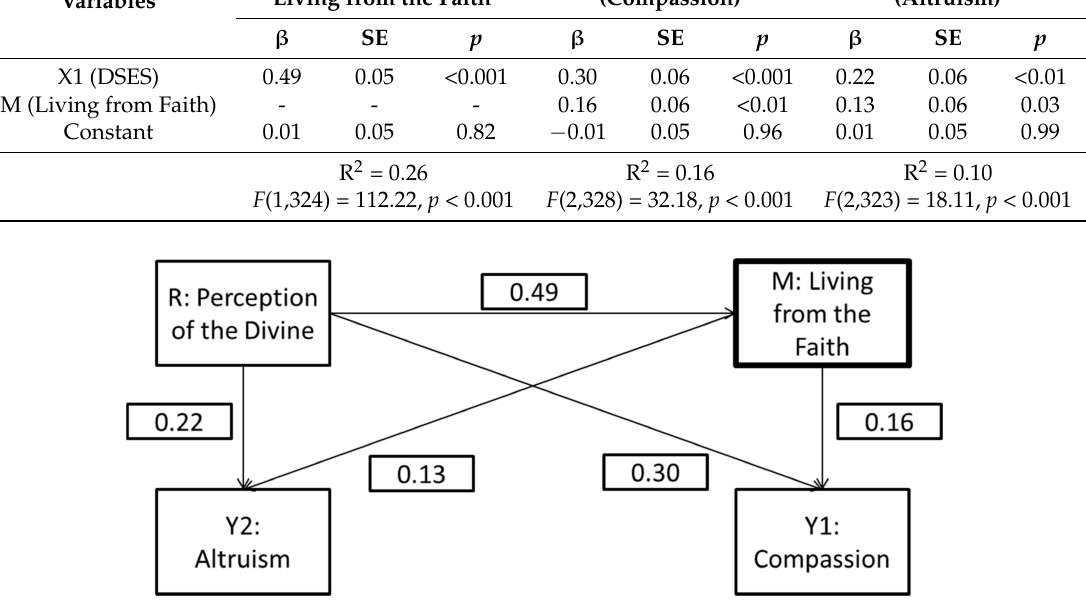
Figure 3. Mediation Model (direct model) for Compassion (Y1) and Altruism (Y2) mediated by “Living from the Faith” (M) and Perception of the Divine as regressor (R). Scores are β